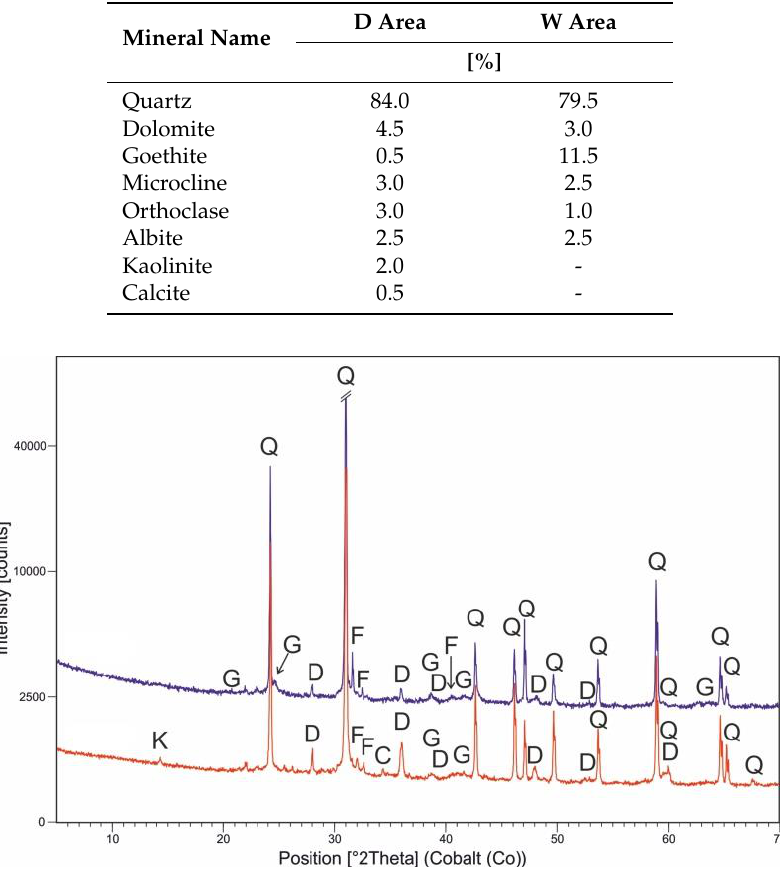
Figure 4. XRD patterns of topsoil from D-Dlugoszyn (red line) and W-Wilkoszyn (blue line) area.